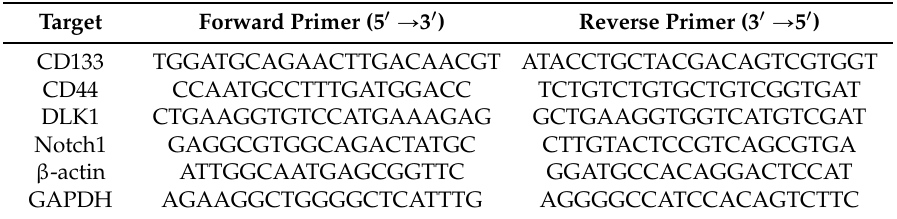
Table 1. Primers for reverse transcriptase polymerase chain reaction